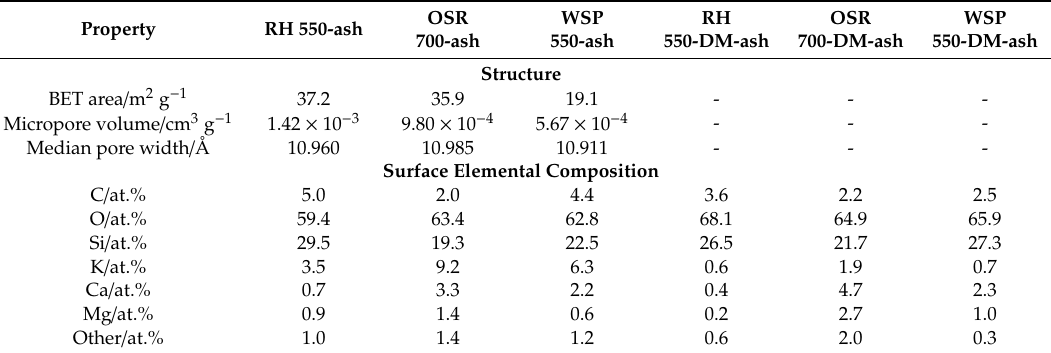
Figure 10. Comparison of production of glycerol carbonate and acetins over biochar from di ff erent feedstocks (rice husk (RH) and oil seed rape (OSR)) before and after demineralization (denoted by –DM). A logarithmic y -axis is used to present high and low concentration products. Table 4. Summary of the characterisation of ash samples from untreated and demineralised (denoted by –DM) biochars from di ff erent feedstocks (rice husk (RH), oil seed rape (OSR) and wheat straw (WSP)). A dash indicates that experimental data are not available. OSR 550-ash was not characterised—the properties are assumed to be comparable to OSR 700-ash. Results for elemental composition reported to one decimal